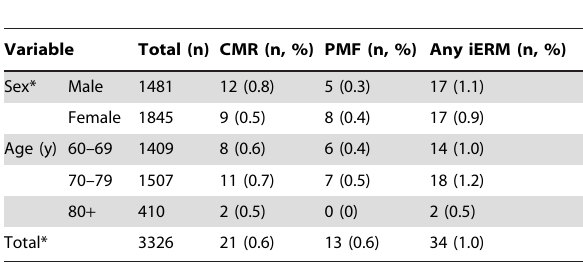
Table 1. Prevalence of idiopathic epiretinal membranes by age and gender.